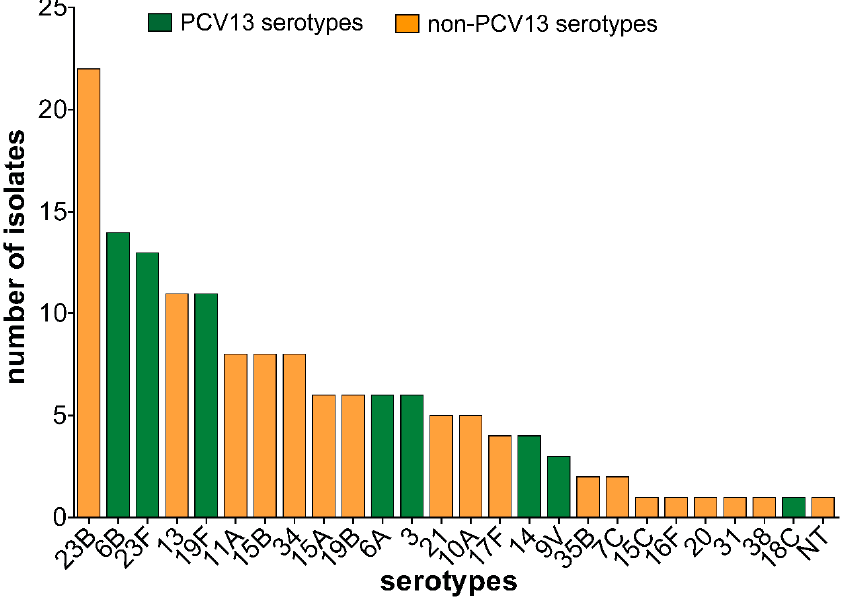
Figure 1. Distribution of vaccine and non-vaccine serotypes. Non-PCV13 serotypes are shown in orange color, while the PCV13 serotypes are shown in green color.